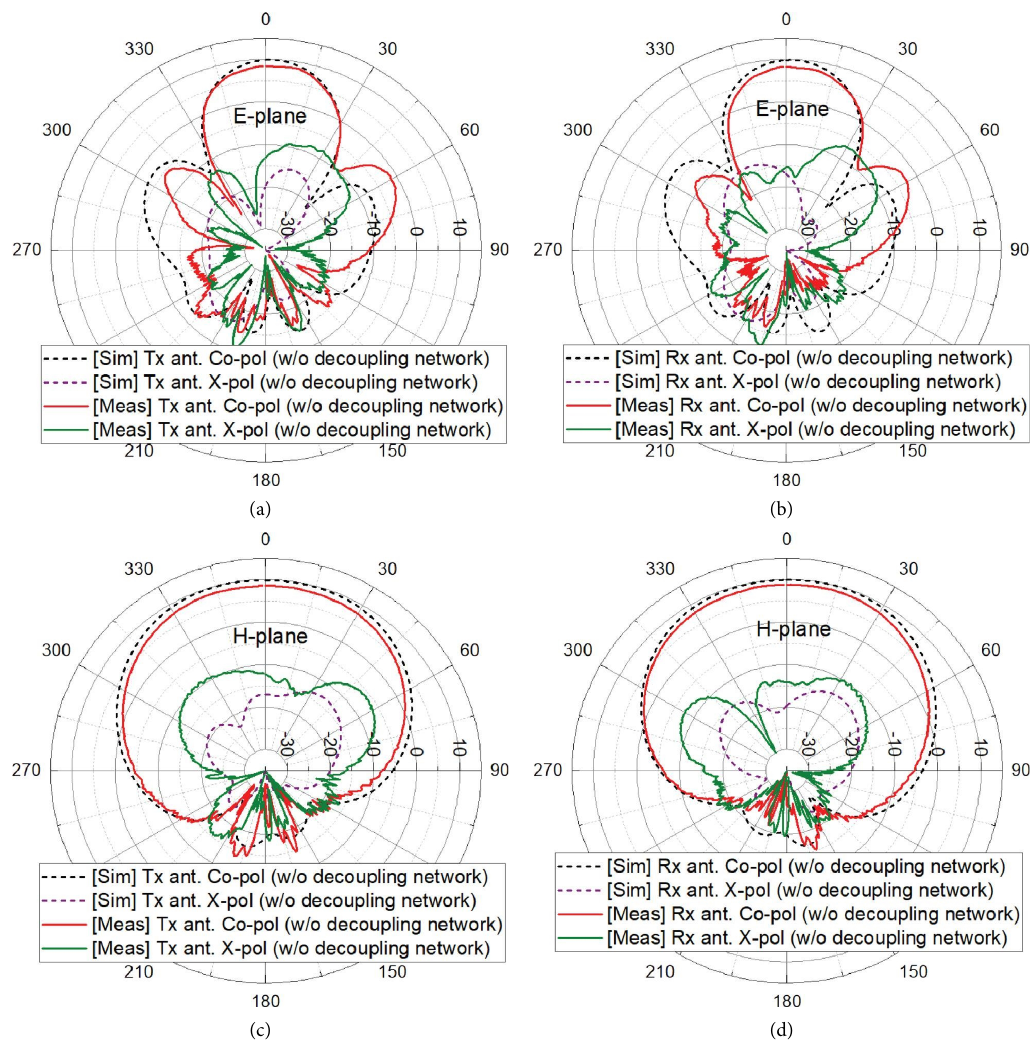
Figure 17: Measured beam patterns of Tx/Rx antennas without the decoupling network at the frequency of 24.1GHz: (a) E-plane of Tx antenna, (b) E-plane of Rx antenna, (c) H-plane of Tx antenna, and (d) H-plane of Rx